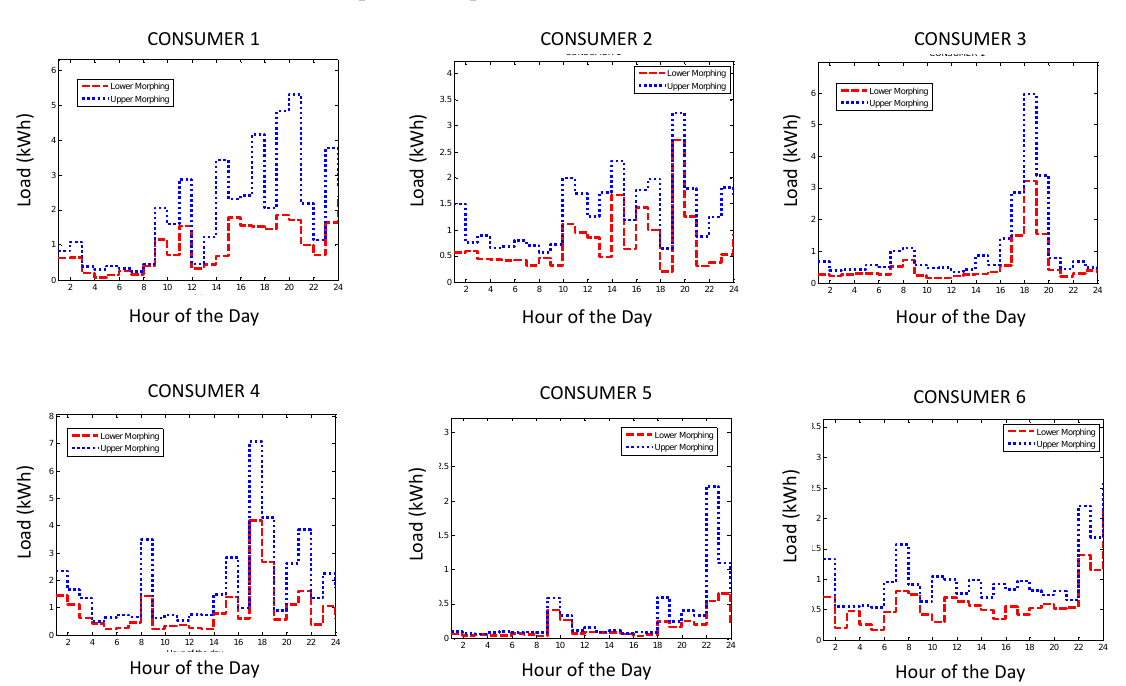
Figure 6. Anticipated load morphing bounds of Consumers 1–6 for test Scenario 1.